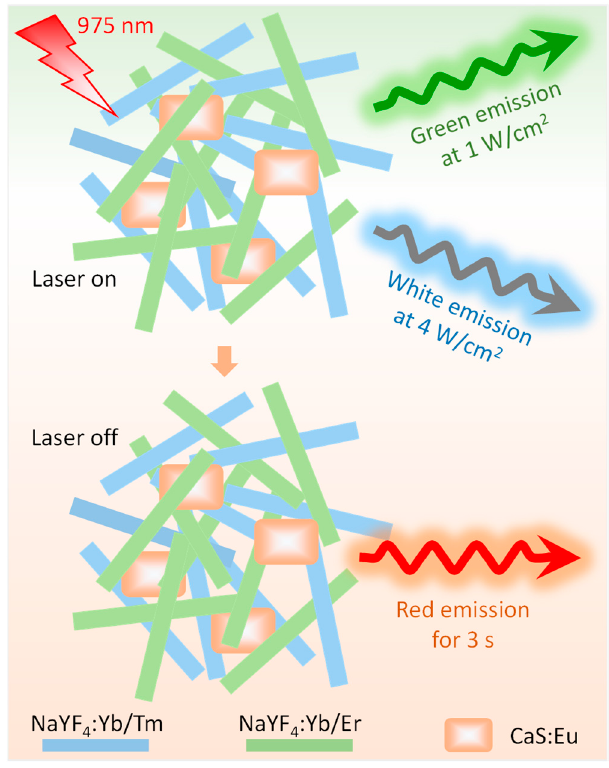
Figure 1. Schematic representation of tricolor emission of ternary hybrids consisting of NaYF 4 :Yb/Tm and NaYF 4 :Yb/Er microrods and CaS:Eu 2+ phosphors induced by laser adjustment and switch.